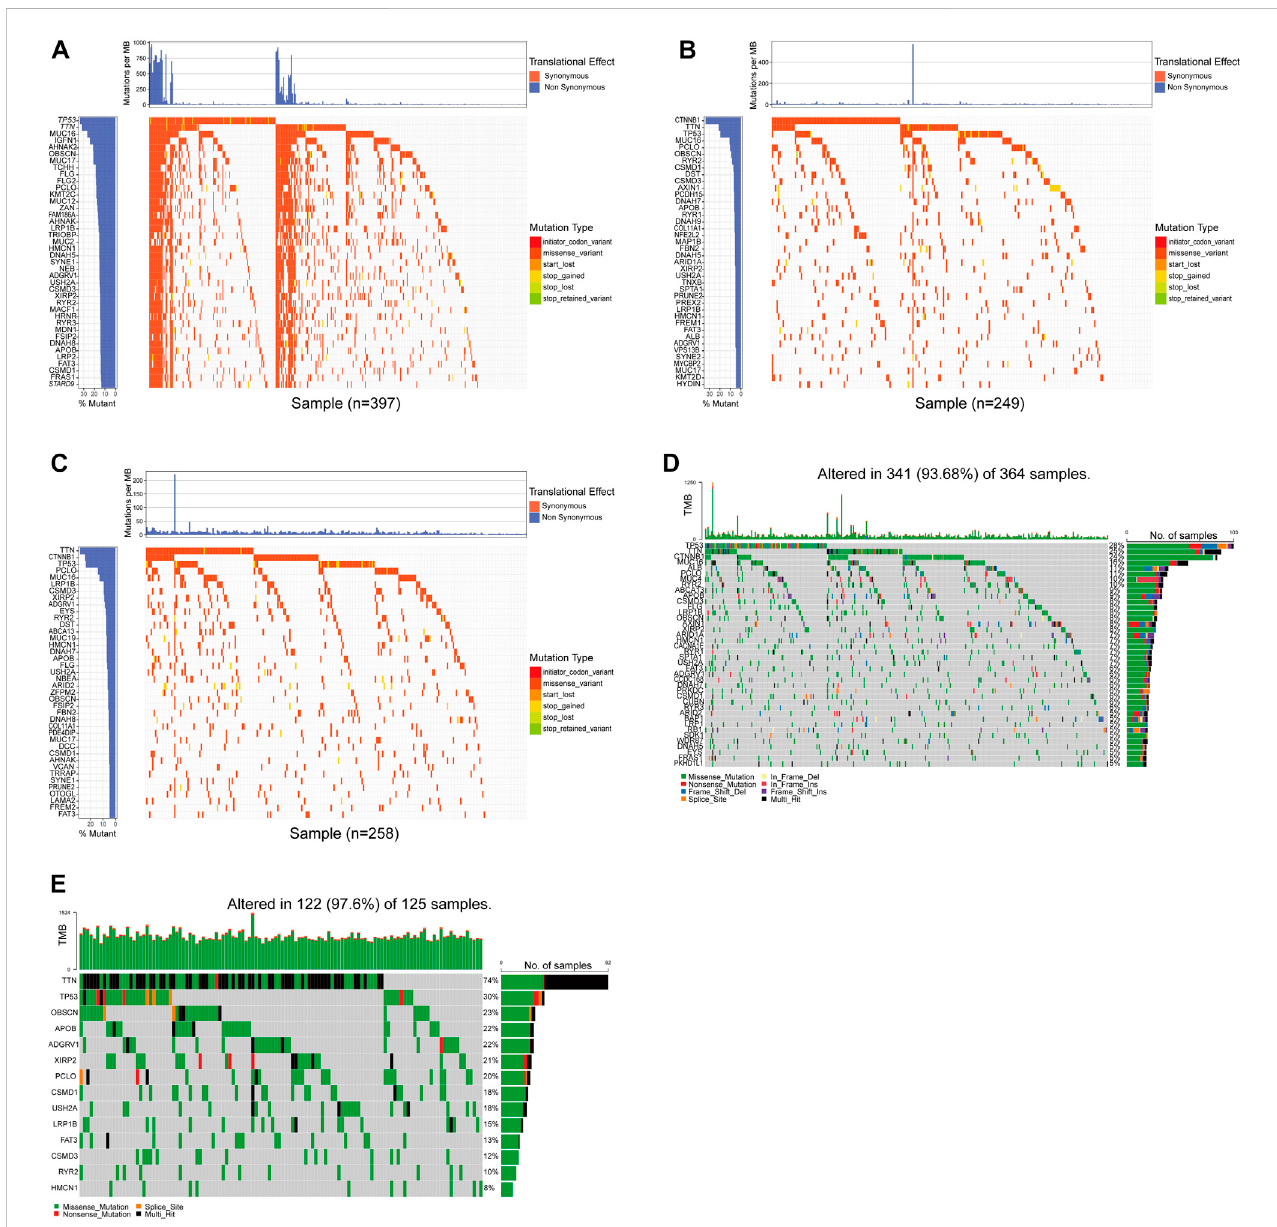
FIGURE 1 Theprimarymutationswerescreenedbywholeexonsequencingandadatabase. (A – D) Thewaterfallchartshowedthetop40genesinthefourcohorts of ICGC-LICA-CN, ICGC-LICA-FR, ICGC-LIRI-JP, and TCGC-LIHC. (E) The mutation pro fi les of 14 repetitive genes in the whole exon sequencing